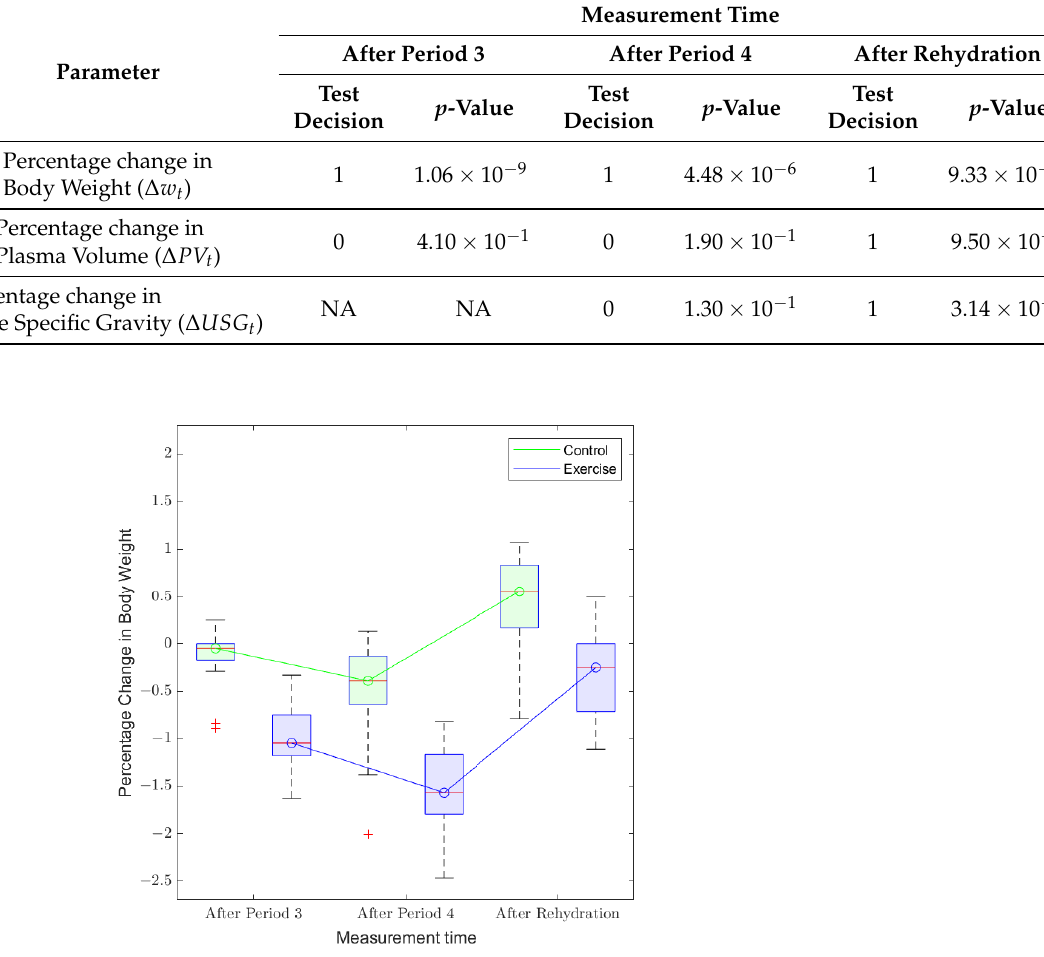
Table 4. Test decisions and p -values of two-sample t -tests for the selection of the parameter that best characterizes hydration in human body (a test decision value of 0 indicates a failure to reject the null hypothesis at 95% confidence level and a value of 1 indicates rejection of the null hypothesis at 95% confidence level).